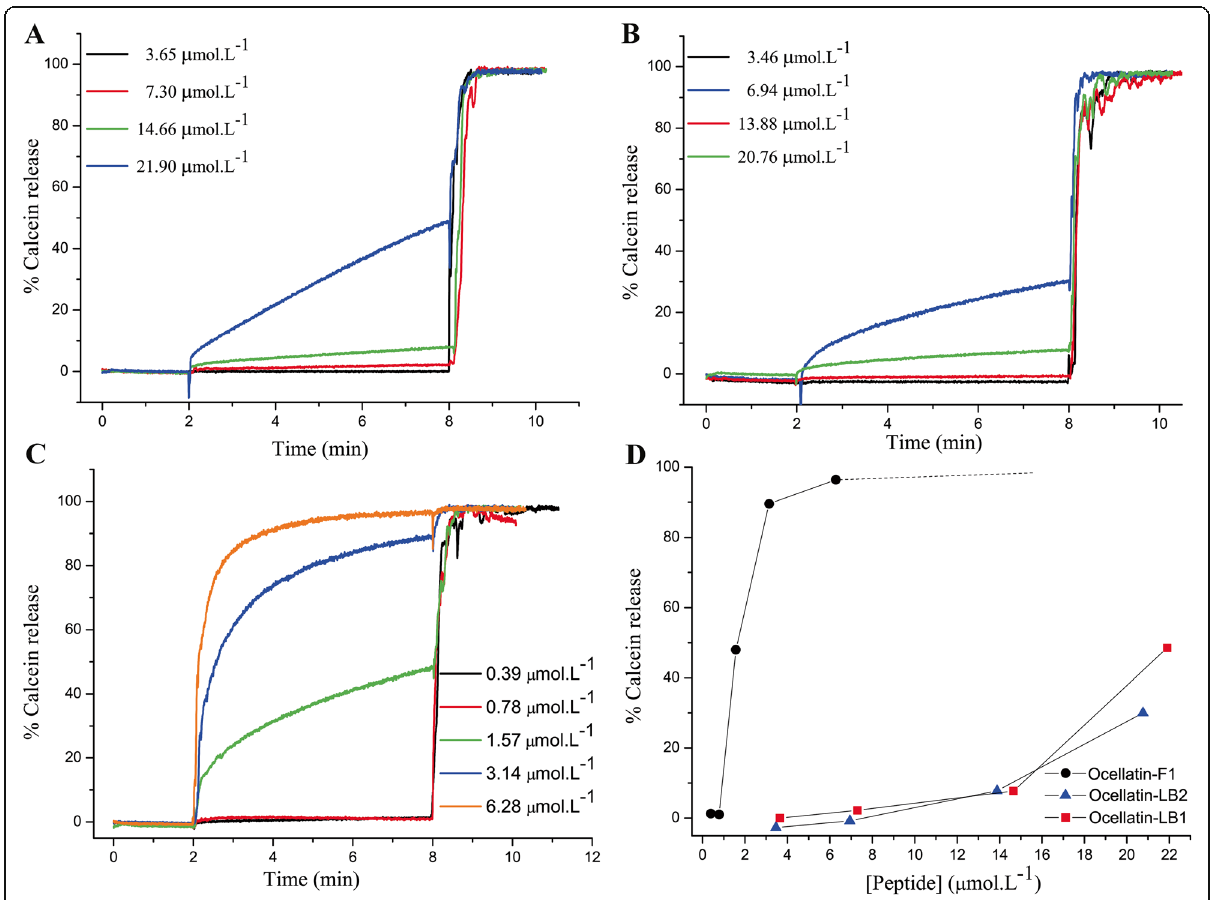
Fig. 4 Kinetics of calcein release from POPC vesicles at 37 °C induced by different concentrations of ( a ) ocellatin-LB1, ( b ) ocellatin-LB2 and ( c ) ocellatin-F1. The vesicle solutions were equilibrated for 2 minutes at 37 °C inside the spectrofluorimeter before the addition of peptide. d Maximum percentage of calcein release as a function of the peptide concentration for ocellatin-LB1 ( red squares ), -LB2 ( blue triangles ) and -F1 ( black circles